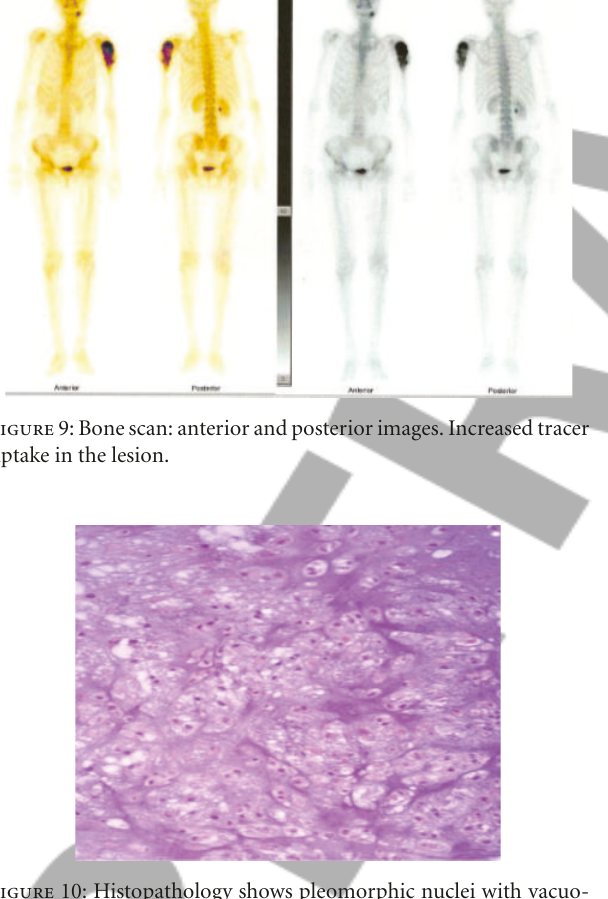
Figure 10: Histopathology shows pleomorphic nuclei with vacuo- lated cytoplasm in chondromyxoid